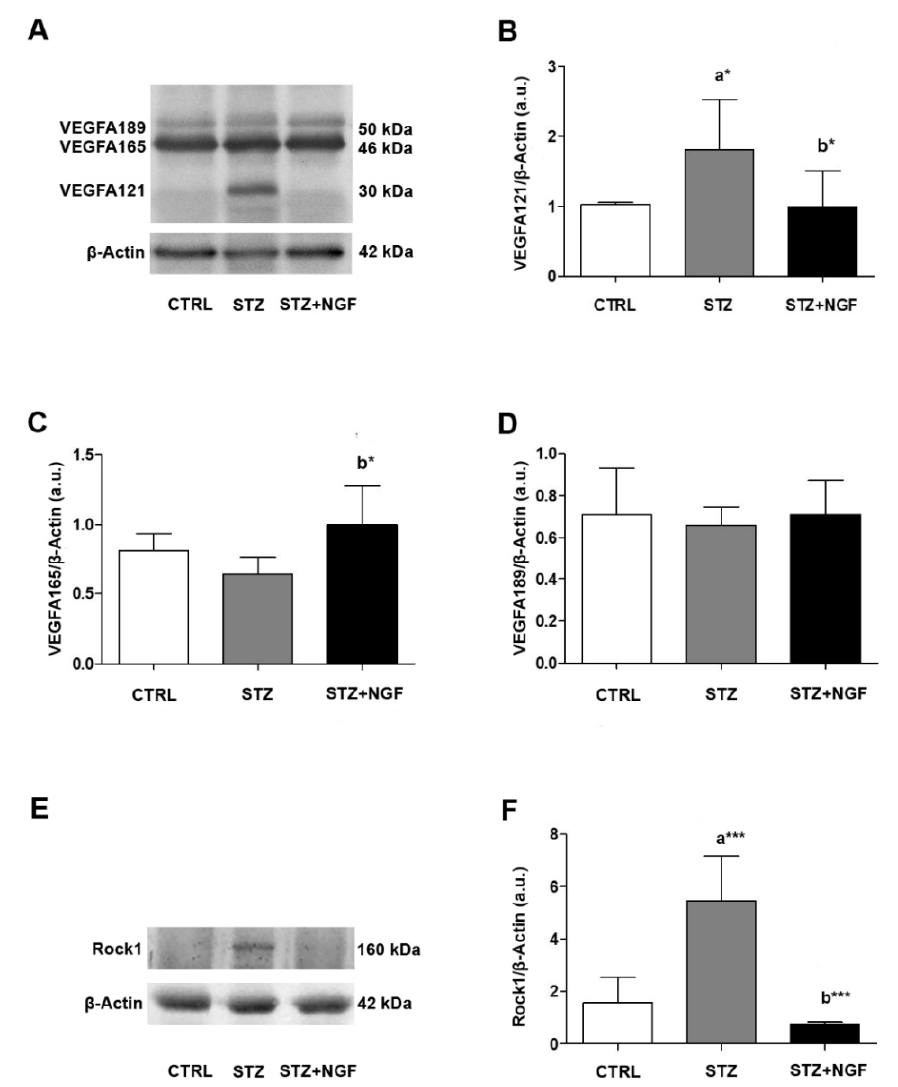
Figure 2. ( A – F ). VEGFA isoforms and Rock1 in diabetic rat retina before and after NGF ocular treatment. Levels of VEGFA isoforms 121, 165, 189 (30 kDa, 46 kDa and 50 kDa, respectively) and Rock1 were affected by diabetes (STZ) and NGF eye drops administration (STZ+NGF) as shown by Western Blots ( A , E ) and densitometric analyses ( B – D , F ). β -Actin expression was used to normalize sample variability; a.u. indicates arbitrary units. The results are expressed as mean ± SD. Statistical significance is indicated with * p < 0.05, *** p < 0.001. “a” vs. CTRL, “b” vs. STZ. CTRL, healthy rats; STZ, streptozotocin; STZ+NGF, streptozotocin+nerve growth factor eye drops.